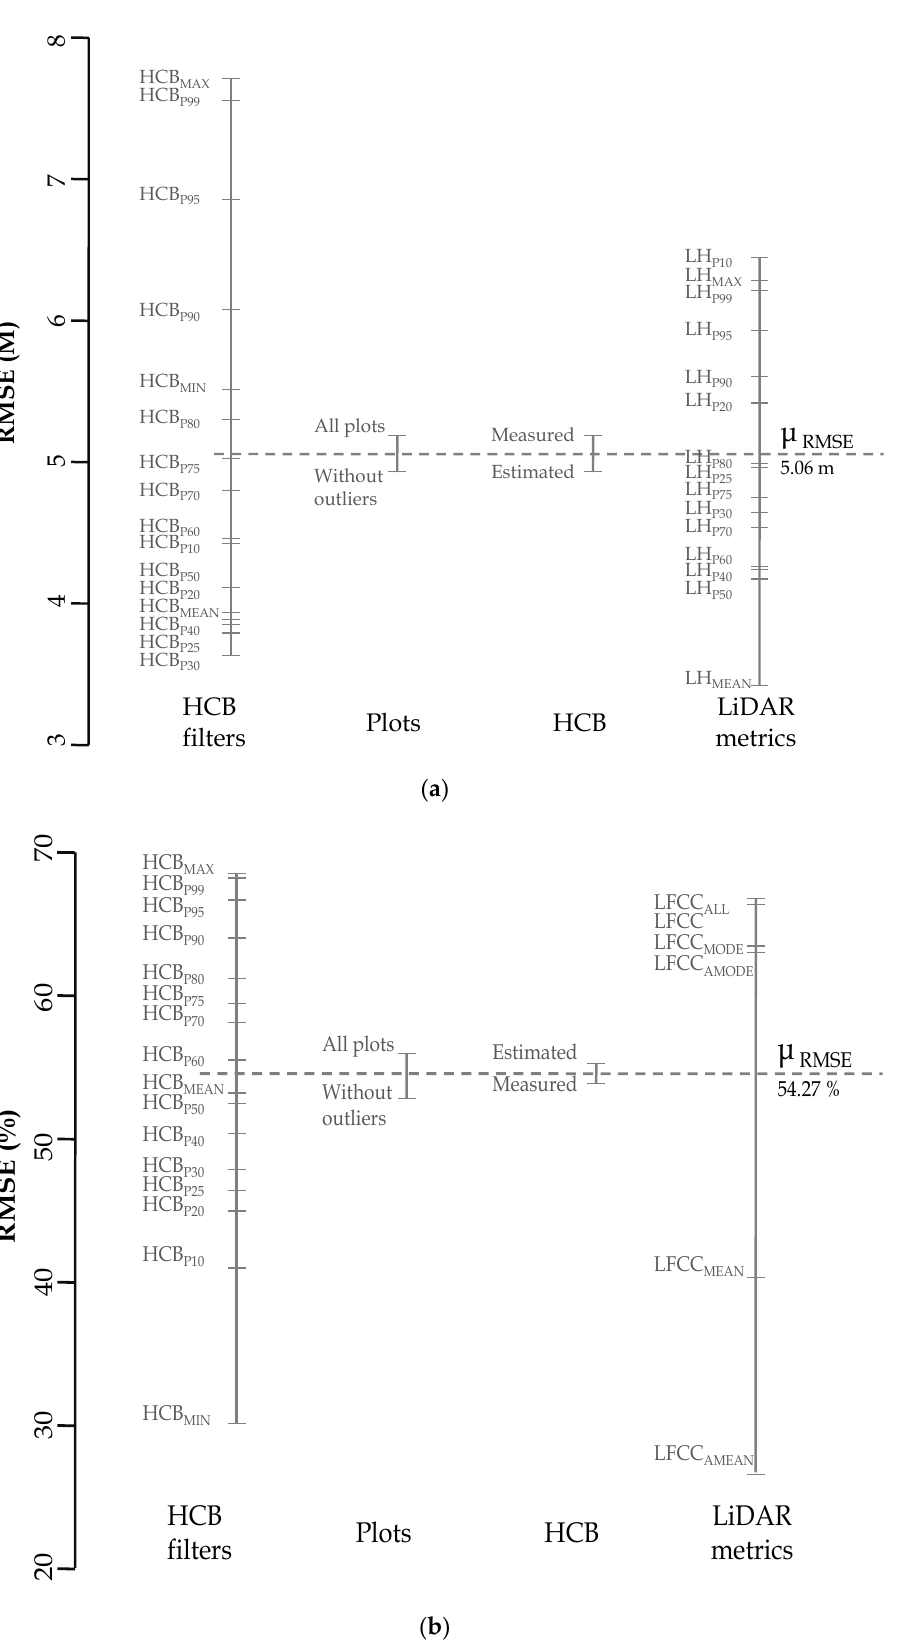
Figure 6. Results of the sensitivity analysis for: ( a ) UH with a mean RMSE of 5.06 m (RMSEr: 77.27%) and ( b ) UC with a mean RMSE of 54.27 percentage cover (RMSEr: